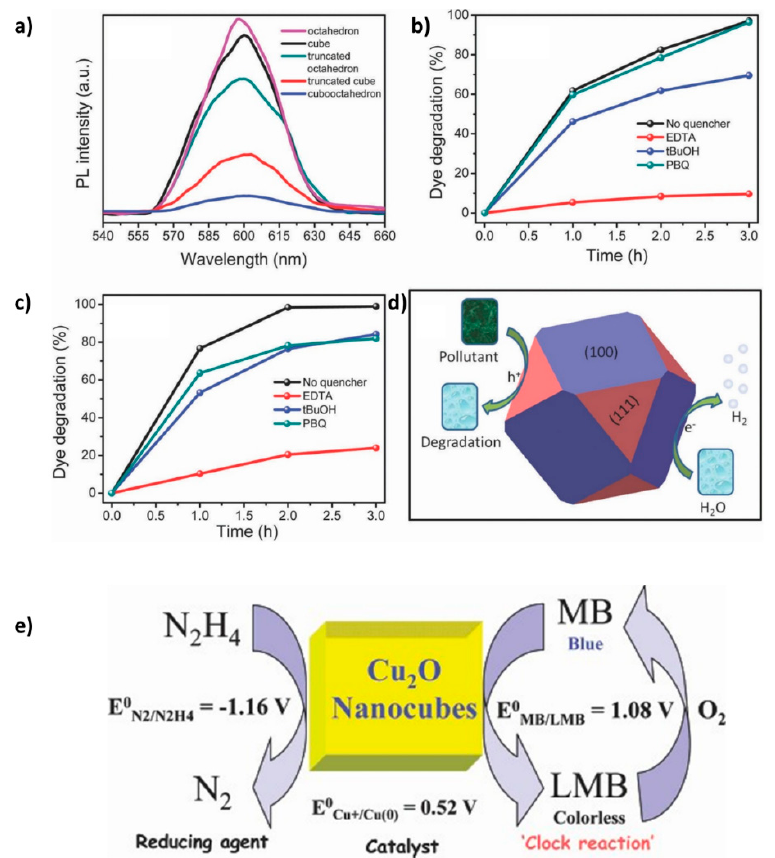
Figure 7. PL spectra of Cu 2 O facet dependent nanocrystal ( a ) with corresponding photocatalytic degradation of RhB over the cuboctahedrons in the presence of radical quenchers in vacuum ( b ), in the atmosphere ( c ), and schematic illustration of their dual-functional photocatalytic mechanism ( d ). Reprinted with permission from ref. [18] Mechanism of ‘clock reaction’ of Cu 2 O nanocubes ( e ). Reprinted with permission from ref. [140].